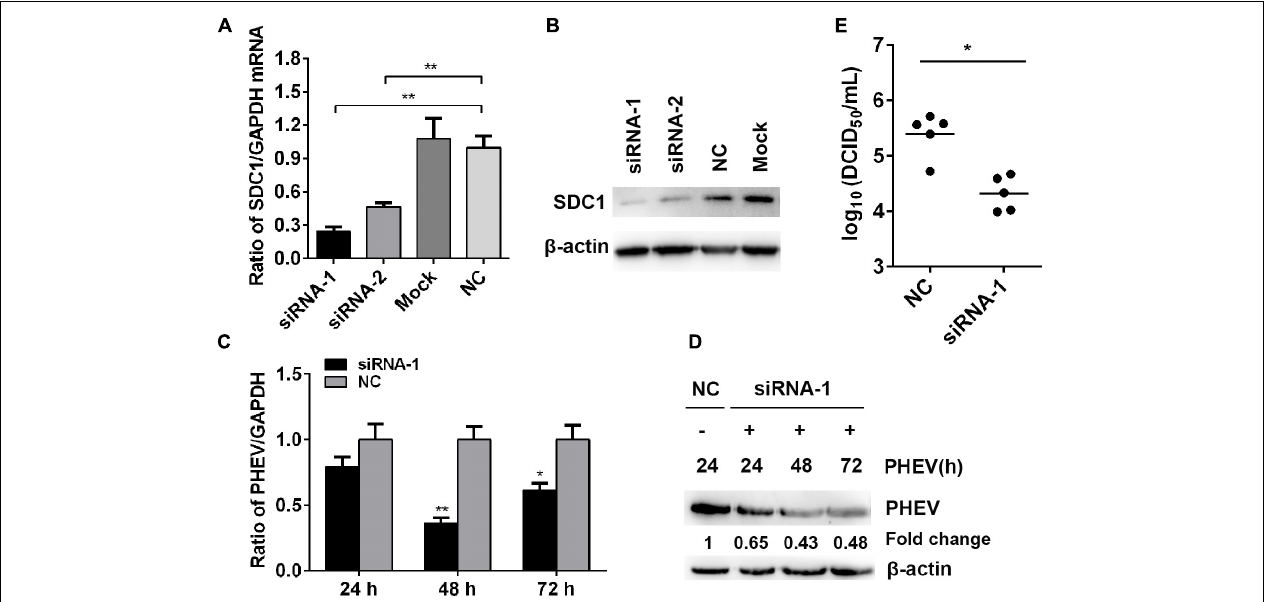
FIGURE 5 | Effects of Syndecan 1 (SDC1) defect in porcine hemagglutinating encephalomyelitis virus (PHEV) replication in vitro . (A) N2a cells were transfected with 50 nM of SDC1-siRNA-1, SDC1-siRNA-2, or negative control (NC) siRNA, and the expression of SDC1 mRNA was determined by qRT-PCR at 24 h post transfection. (B) The protein levels of SDC1 in the cell treated as described in panel (A) were determined by western blotting. (C) N2a cells were infected with PHEV for 24 ∼ 72 h, following SDC1-siRNA-1 transfection, and the levels of the viral genome RNA were detected by qRT-PCR. (D) Cells treated as indicated in panel (C) were harvested and determined by western blotting. (E) Viral titers in the supernatants were measured by TCID 50 /ml assay. Data are shown as means ± SD of at least three independent experiments. * p < 0.05; ** p <